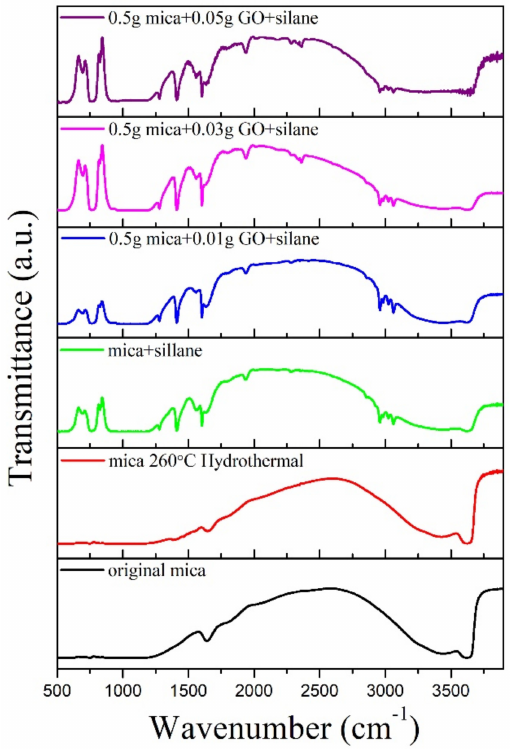
Figure 3. Fourier transform infrared (FTIR) spectra of mica and mica/graphene oxide before and after functionalization with